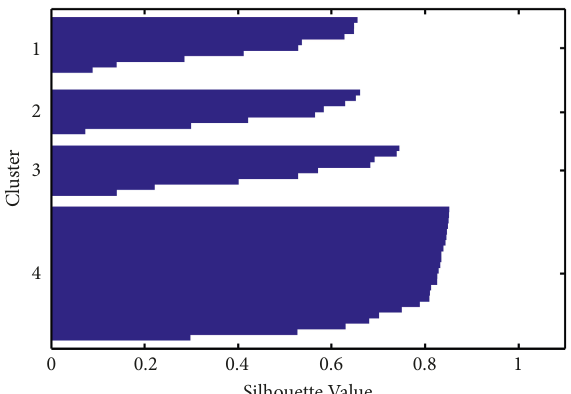
Figure 7: Silhouette value of the scroll wheel damage character- istics divided into four